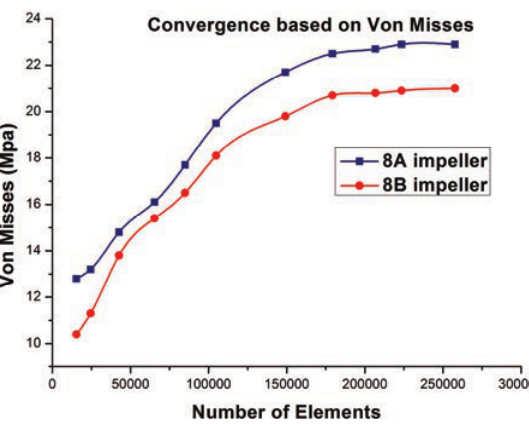
Fig.8. Convergence graph for 3-D FE model Figure 8. Convergence graph for 3-D FE